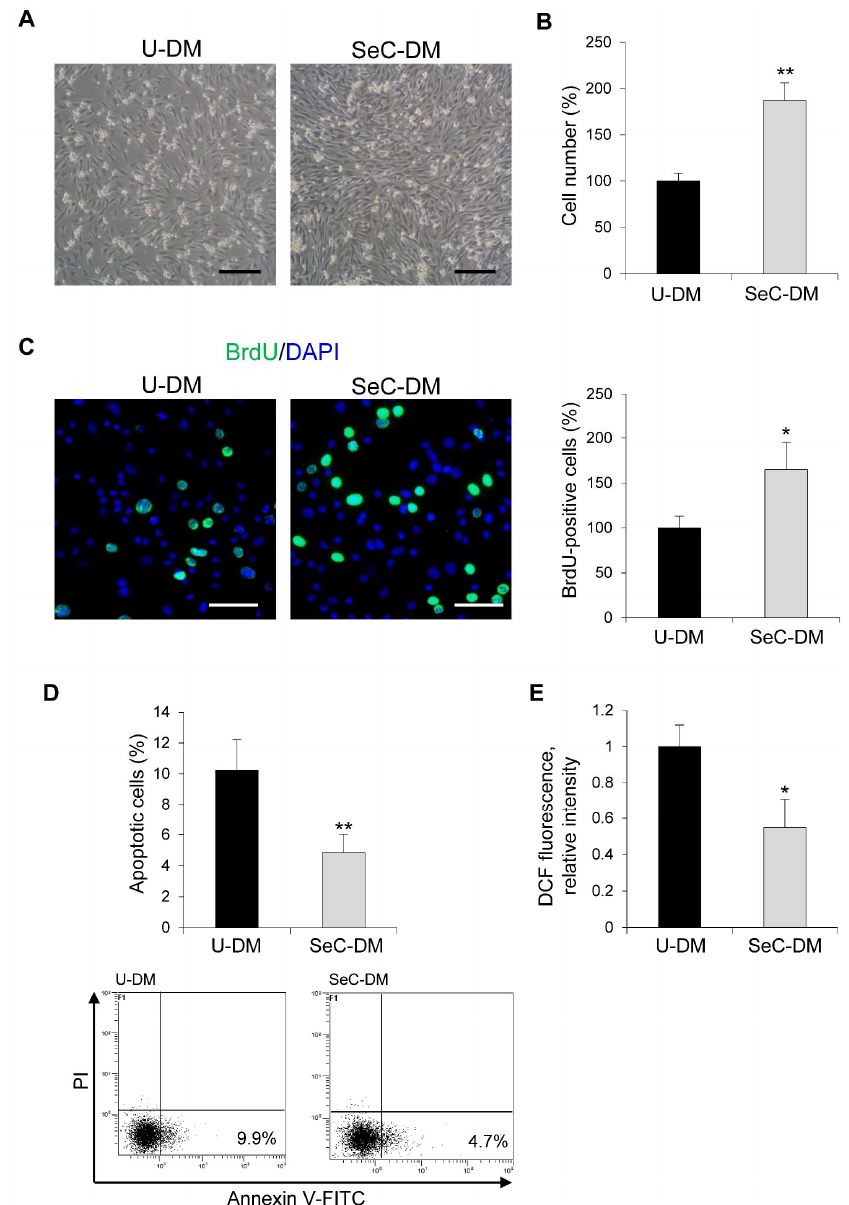
Figure 1. SeC increase C2C12 myoblast numbers in the early phase of the differentiation process. ( A – E ) C2C12 myoblasts were cultivated for 24 h in the presence of unconditioned differentiation medium (U-DM) or DM conditioned by Sertoli cells (SeC-DM). ( A ) Myoblast cultures were observed by phase contrast microscopy (representative images). ( B ) Cell count and ( C ) BrdU assay were performed to evaluate the percentage differences in the number of cells or proliferating cells, respectively. Reported are representative merged images of BrdU (green) and DAPI (blue) used to counterstain nuclei. ( D ) The percentages of apoptotic cells were determined by FACS analysis after annexin V-FITC and propidium iodide (PI) staining. Representative scatterplots are reported. ( E ) The 2 (cid:48) ,7 (cid:48) -dichlorofluorescein (DCF) fluorescence was measured to evaluate the intracellular levels of reactive oxygen species (ROS). Results are means of three independent experiments ( ± SD). * and **, significantly different from U-DM ( p < 0.05 and p < 0.01, respectively). Scale bars, 200 µ m ( A ) and 100 µ m ( C